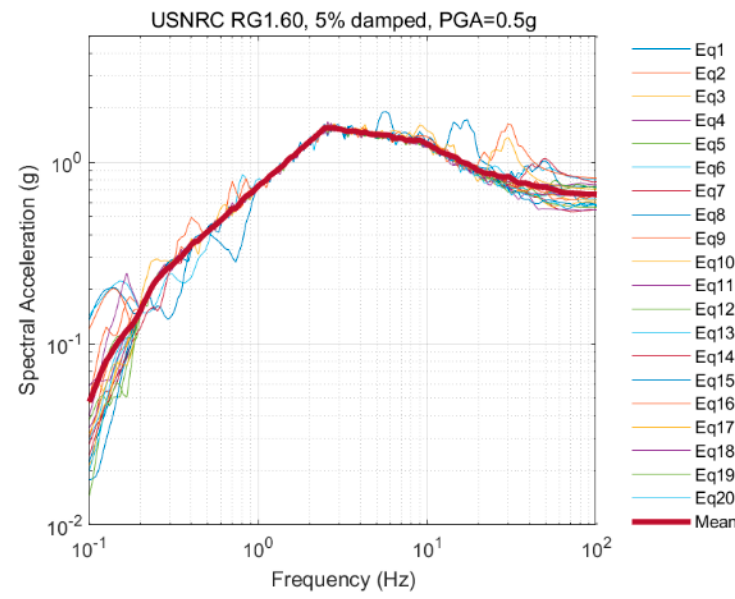
Figure 6. Acceleration response spectra for 20 motions (PGA = 0.5 g).